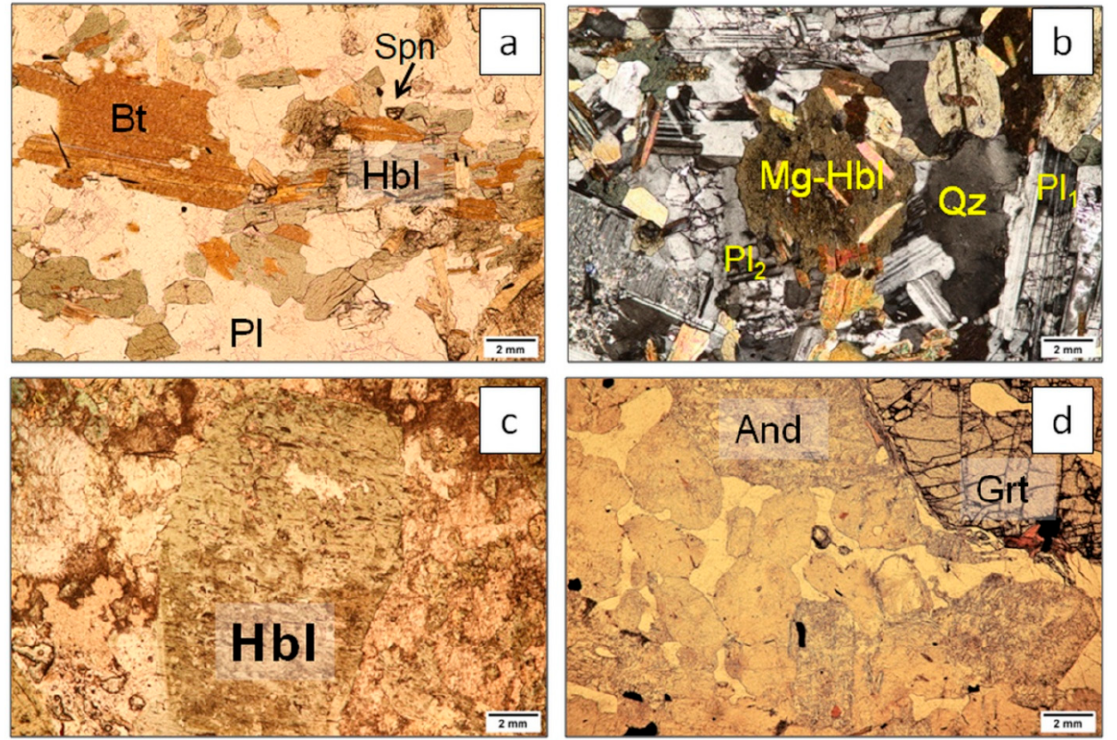
Figure 7. ( a ) Plane polarized light (PPL) image of green hornblende (Mg-Hbl), biotite (Bt) and sphene (Spn) in the plagioclase groundmass of MOD (sample A3357) ( b ) XPL image displaying two generations of plagioclase (euhedral phenocrysts, Pl 1 and subhedral to anhedral crystals Pl 2 ) in MOD (sample A3357). ( c ) PPL image of a hornblende phenocrystal (Hbl) from coarse grained MPD (sample A3355). ( d ) PPL image of M. Ospedale contact rock with garnet (Grt) and andalusite